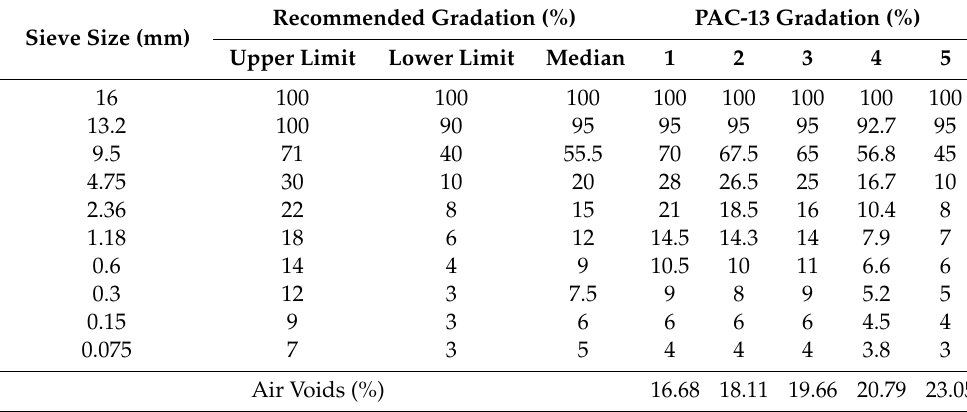
Table 1. The results of PAC-13 aggregate gradation.